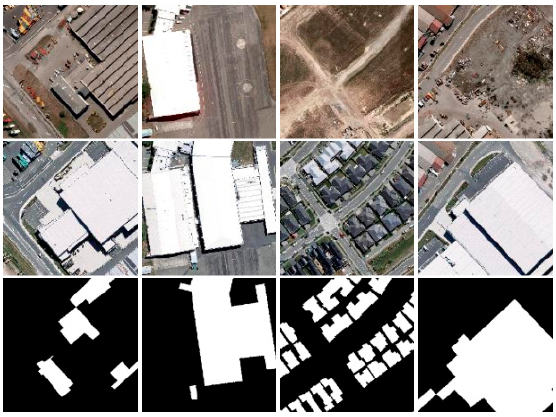
Remote Sens. 2023 , 15 , 694 12 of 25 Figure 6. Image patch examples and corresponding reference images of the WHU-CD data set. Figure 6. Image patch examples and corresponding reference images of the WHU-CD data set. Figure 6. Image patch examples and corresponding reference images of the WHU-CD data set.